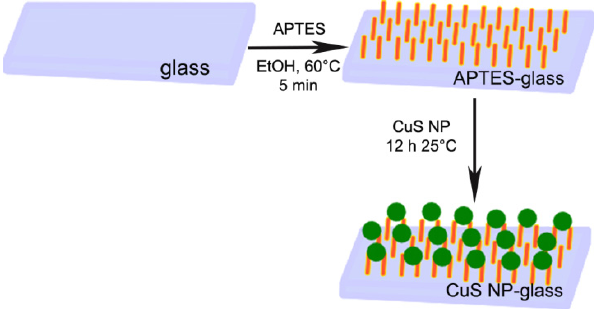
Scheme 1. Schematic representation for the preparation of CuS NP-glass samples.